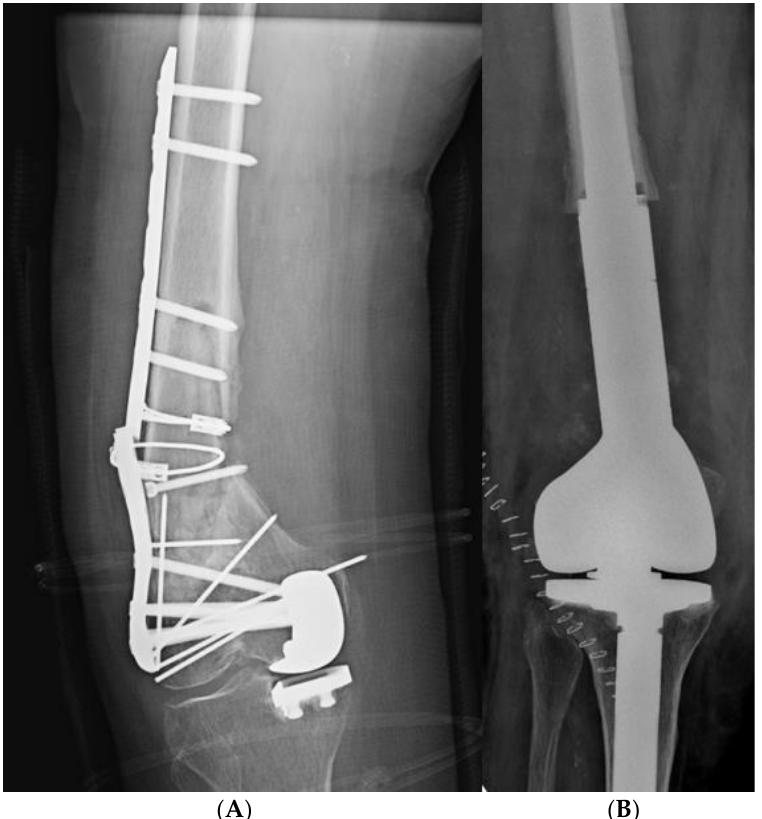
Figure 2. 80-year-old patient with 33-A2 femur fracture. ( A ) Anteroposterior X-ray of the femur showing a PSA is present in the distal third of the femoral diaphysis, associated with mono-compartmental knee prothesis, broken plate, multiple Kirshner wires and metal cerclages. ( B ) Anteroposterior knee X-ray showing knee mega prosthesis implantation as revision surgery.